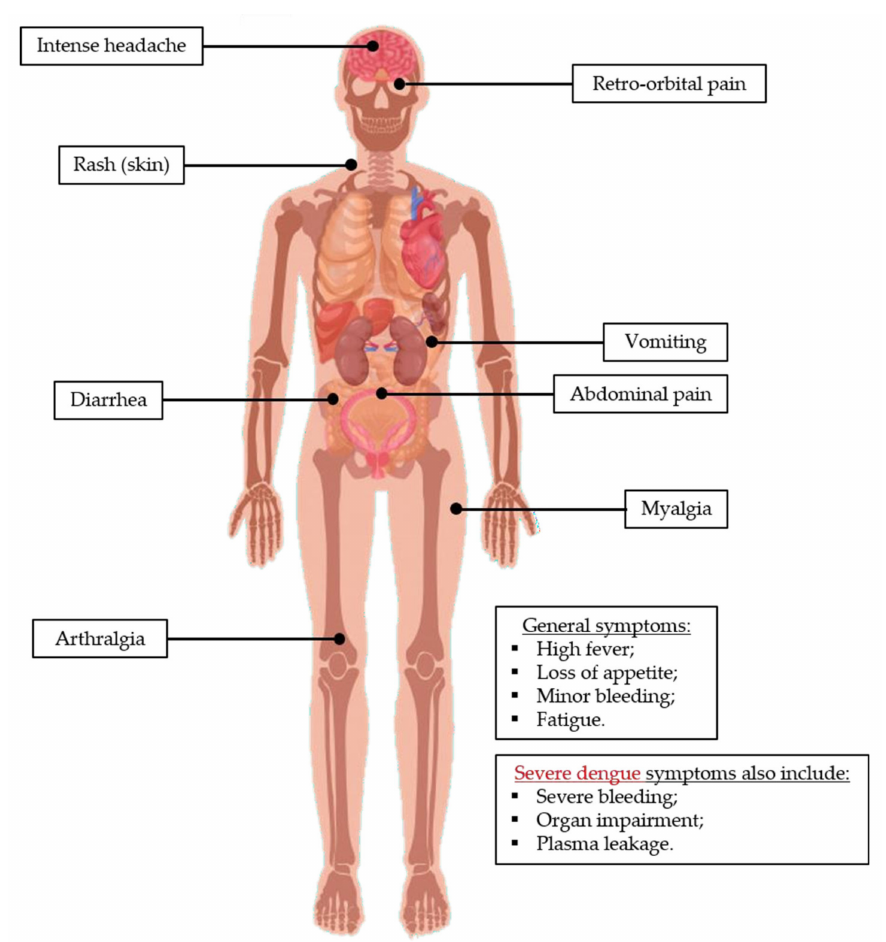
Figure 5. Dengue infection clinical symptoms. The typical clinical manifestations of dengue include flu-like symptoms, namely headache, fever, and fatigue, plus a number of more specific symptoms such as rash and severe myalgia and arthralgia. When it evolves to severe cases, it can induce bleeding, organ impairment, and loss of fluids, all of which may lead to death. This image has been designed using resources from